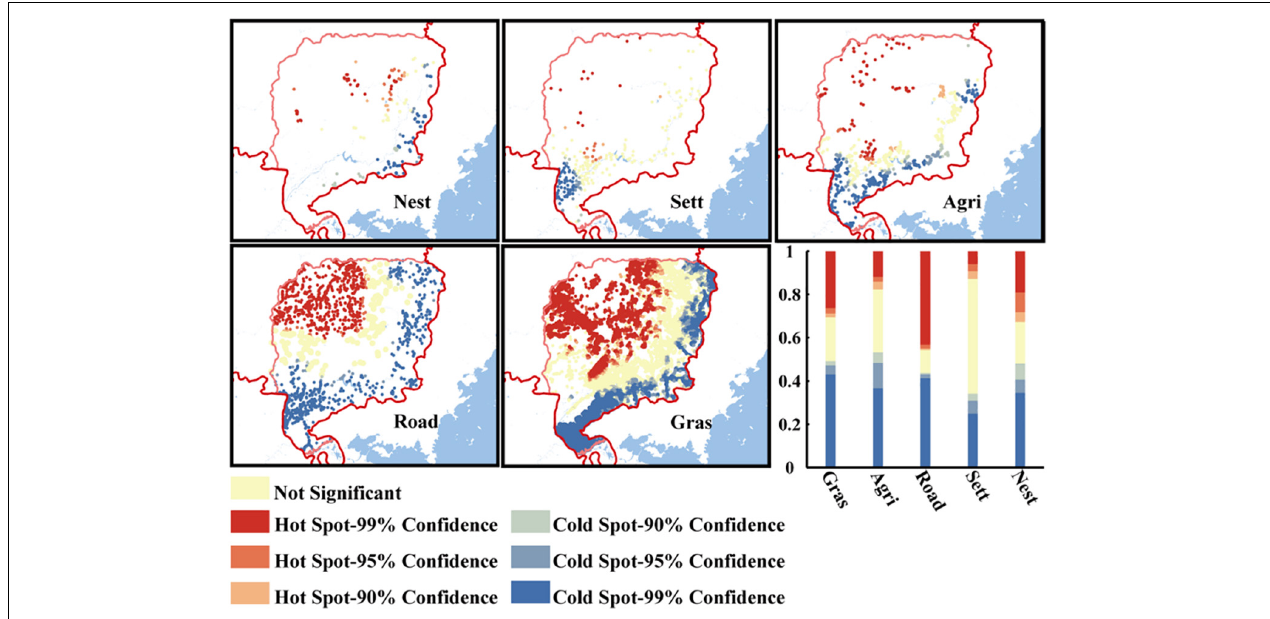
FIGURE 2 | The number of hot and cold spots of anthropogenic pressure. This analysis judges the characteristics of cold spots and hot spots at the three confidence levels of 99, 95, and 90%. Hot spot means aggregation far from the borderline and cold spot means aggregation close to the borderline of anthropogenic pressure factors and wild boar nests within study